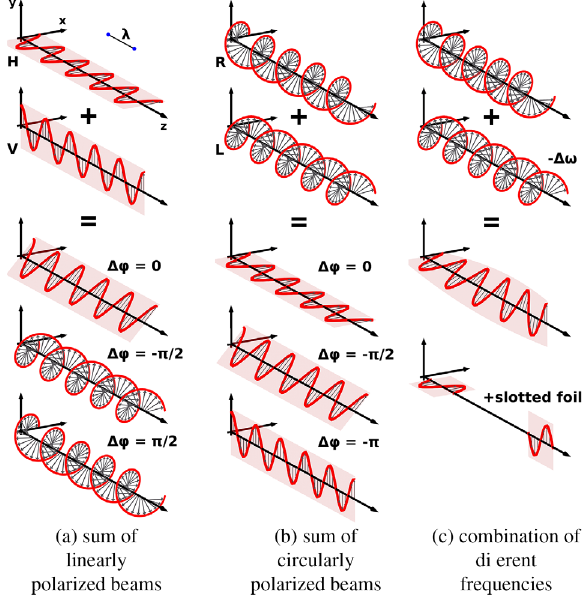
FIG. 2. Combination of radiation beams with different polar- izations. Note that for illustration purposes the depicted rate of polarization change on subfigure (c) is exaggerated.